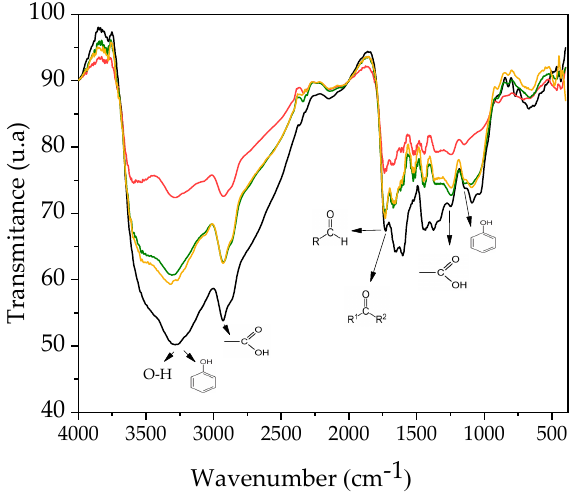
Figure 3. FTIR spectra of coffee husks. Symbols: − untreated biomass; − pretreated biomass with acetic acid (10 wt%); − pretreated biomass with HNO 3 (0.1 wt%) / H 2 SO 4 (0.1 wt%); − pretreated biomass with H 2 SO 4 (0.1 wt%).